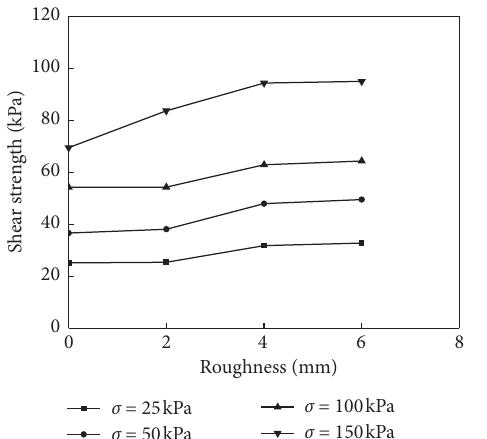
Figure 9: Relationship between shear strength of interface and